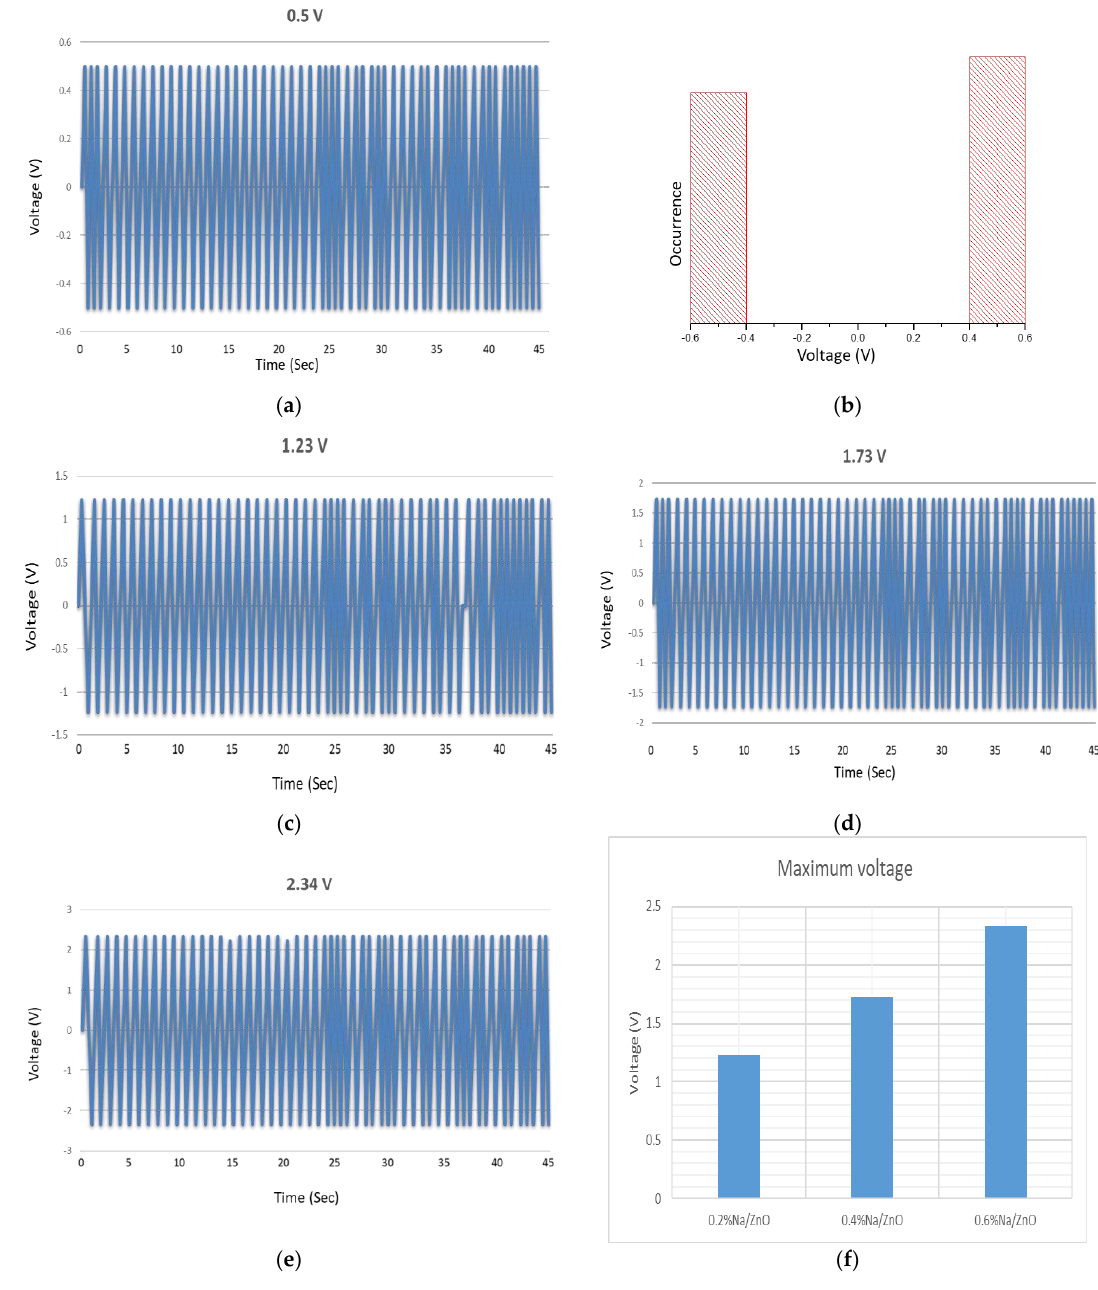
Figure 7. Output voltage values generated by ZnO nanowires based VING, ( a ) as-grown, ( c ) 2%Na/ZnO ( d ) 4% Na/ZnO ( e ) 6% Na/ZnO ( b ) voltage histogram, ( f ) voltage bar graph for various Na doping concentrations. Figure 8a represents the piezoelectric voltage generation by un-doped ZnO nanowires and Figure 8b shows voltage occurrence range for positive and negative voltage.